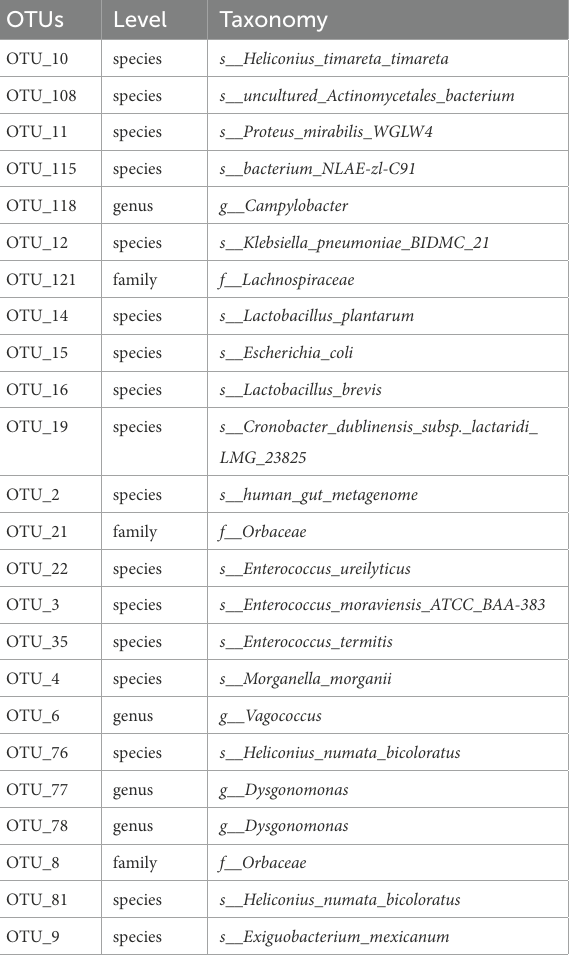
TABLE 6 All gnotobiotic samples core OTUs for 16S rDNA amplicons.